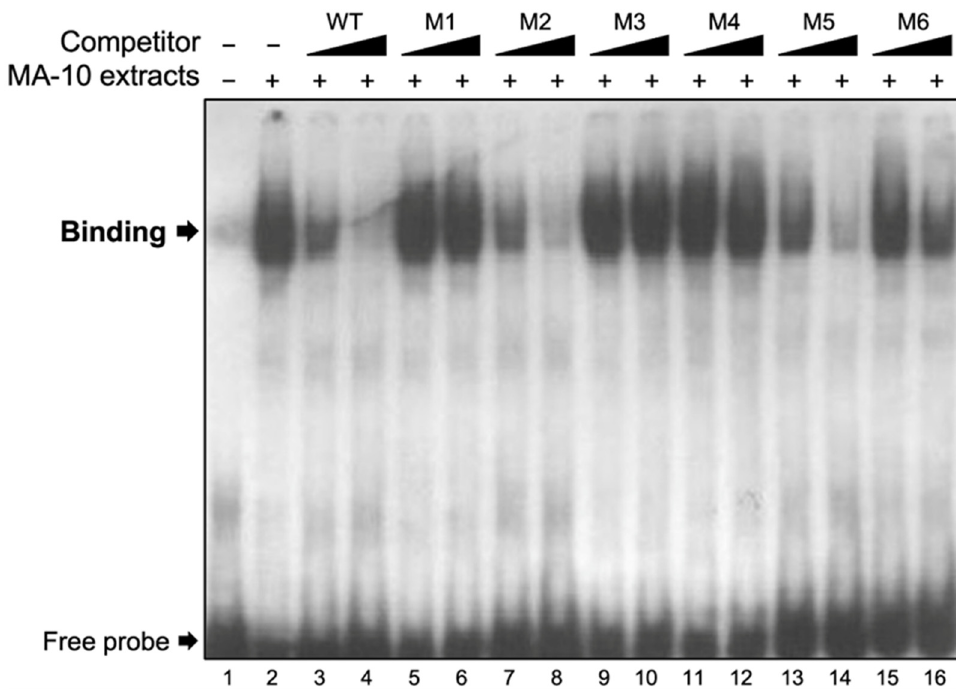
Figure 4. Nuclear proteins from MA-10 cells bind specifically to the 35-bp region. EMSA was used to determine the binding of nuclear extracts from MA-10 Leydig cells (MA-10 extracts) to a double- stranded 32 P-labelled oligonucleotide corresponding to the 35-bp region ( − 186 to − 151 bp) of the Insl3 promoter. Protein binding was challenged by increasing concentrations (black triangles; molar excesses of 5× and 25×) of unlabelled oligonucleotides corresponding to the wild-type 35-bp region (WT) or oligonucleotides containing linker-scanning mutations (M1, M2, M3, M4, M5, M6; defined in Figure 3) in the 35-bp region.